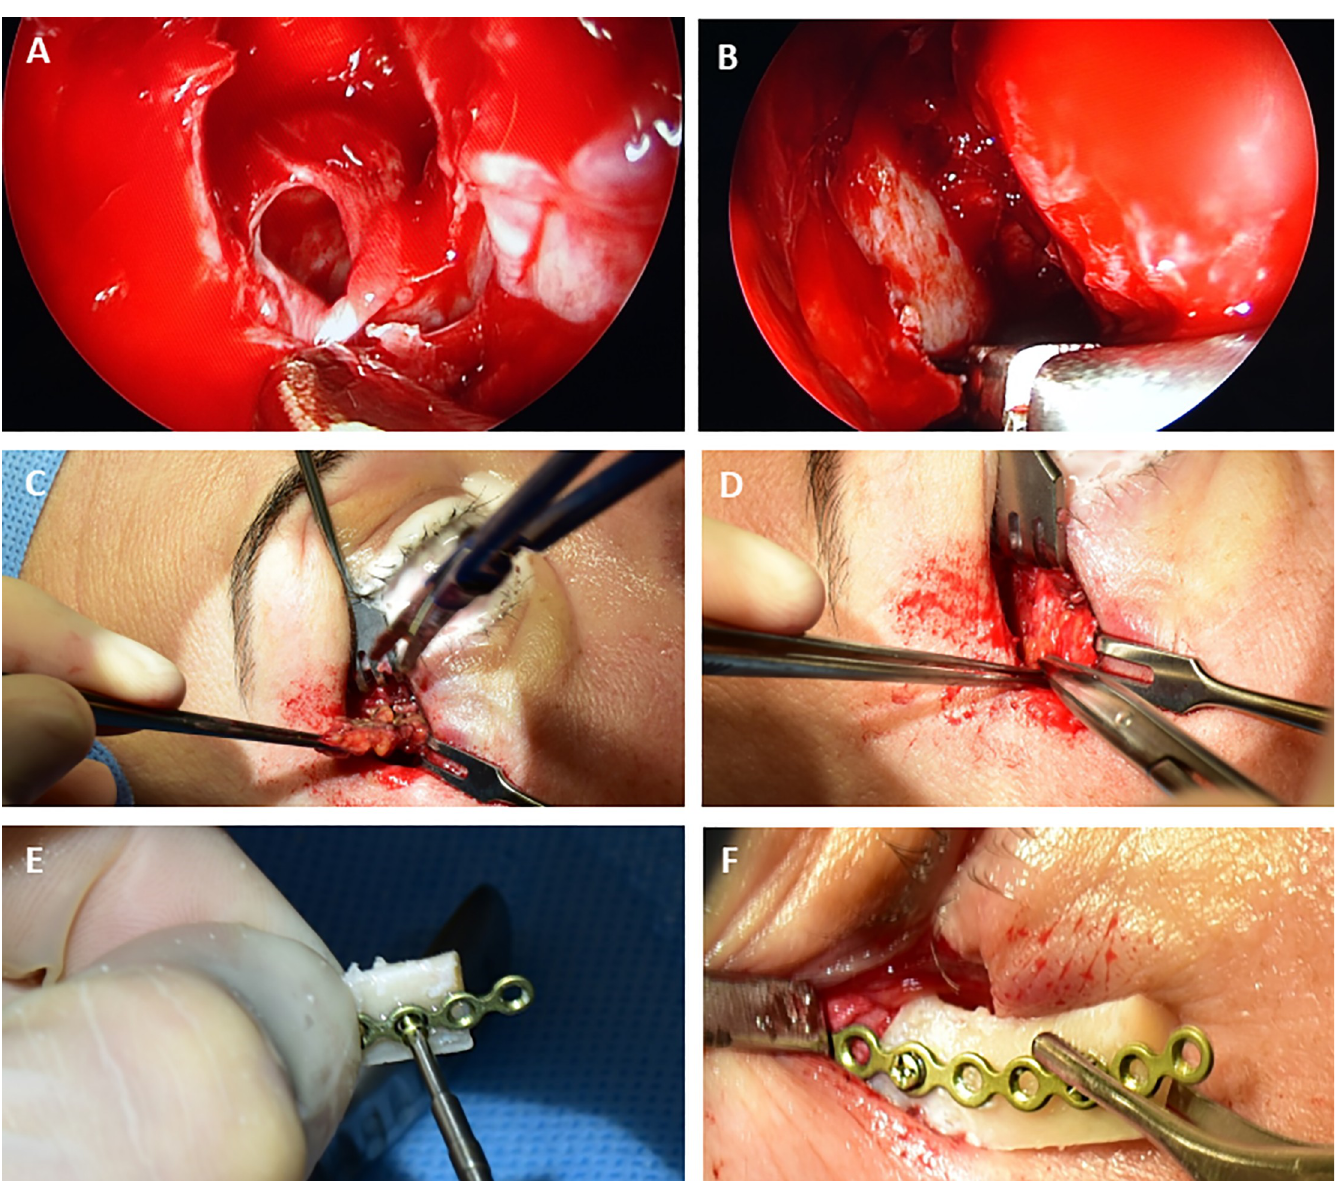
Fig 1. All patients underwent balanced orbital decompression. The extent of surgery was chosen according to the individual proptosis. (A-B) The medial wall was decompressed via endonasal endoscopy. The periorbit was incised allowing the orbital content to prolapse into the ethmoid cavity. (C-D) Resection of a bony triangle of the lateral wall was performed through a 10mm incision next to the lateral canthus. (E-F) To restore the lateral orbital rim, the anterior part of the resected bone is replanted employing a fixation with